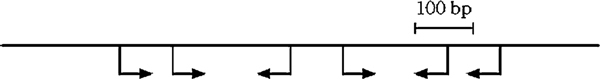
Map including the localizations of PCR primers on Triticum aestivum 18S rDNA gene.